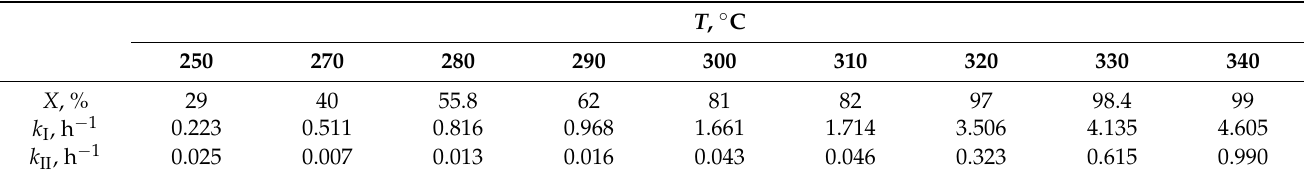
Table 3. Parameters for the reaction of cyclohexane dehydrogenation (LHSV = 1 h − 1 , P = 1 atm). T , ◦ C